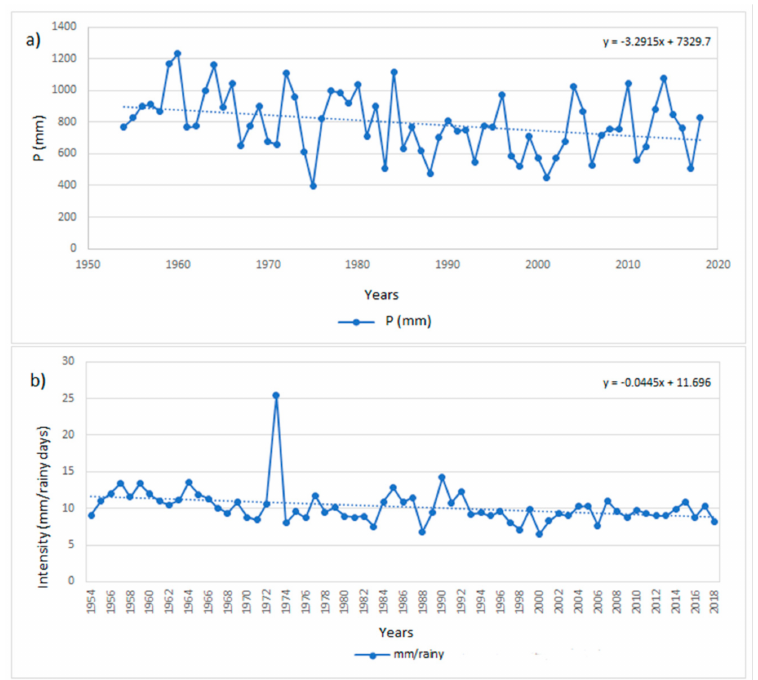
Figure 10. Pluviometric pattern for the study area: ( a ) Distribution of average annual precipitation during the observation period; ( b ) annual intensity (mm/rain day).